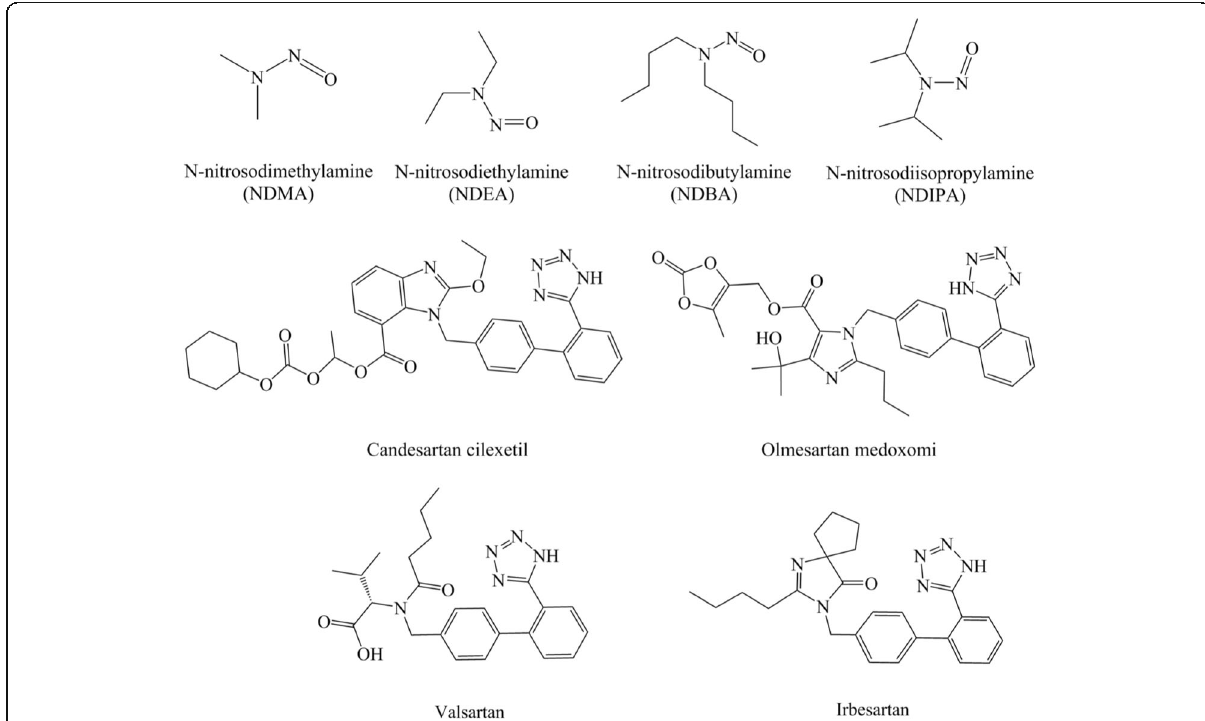
Fig. 1 Molecular structures of four N-nitrosamines and sartan substances in this